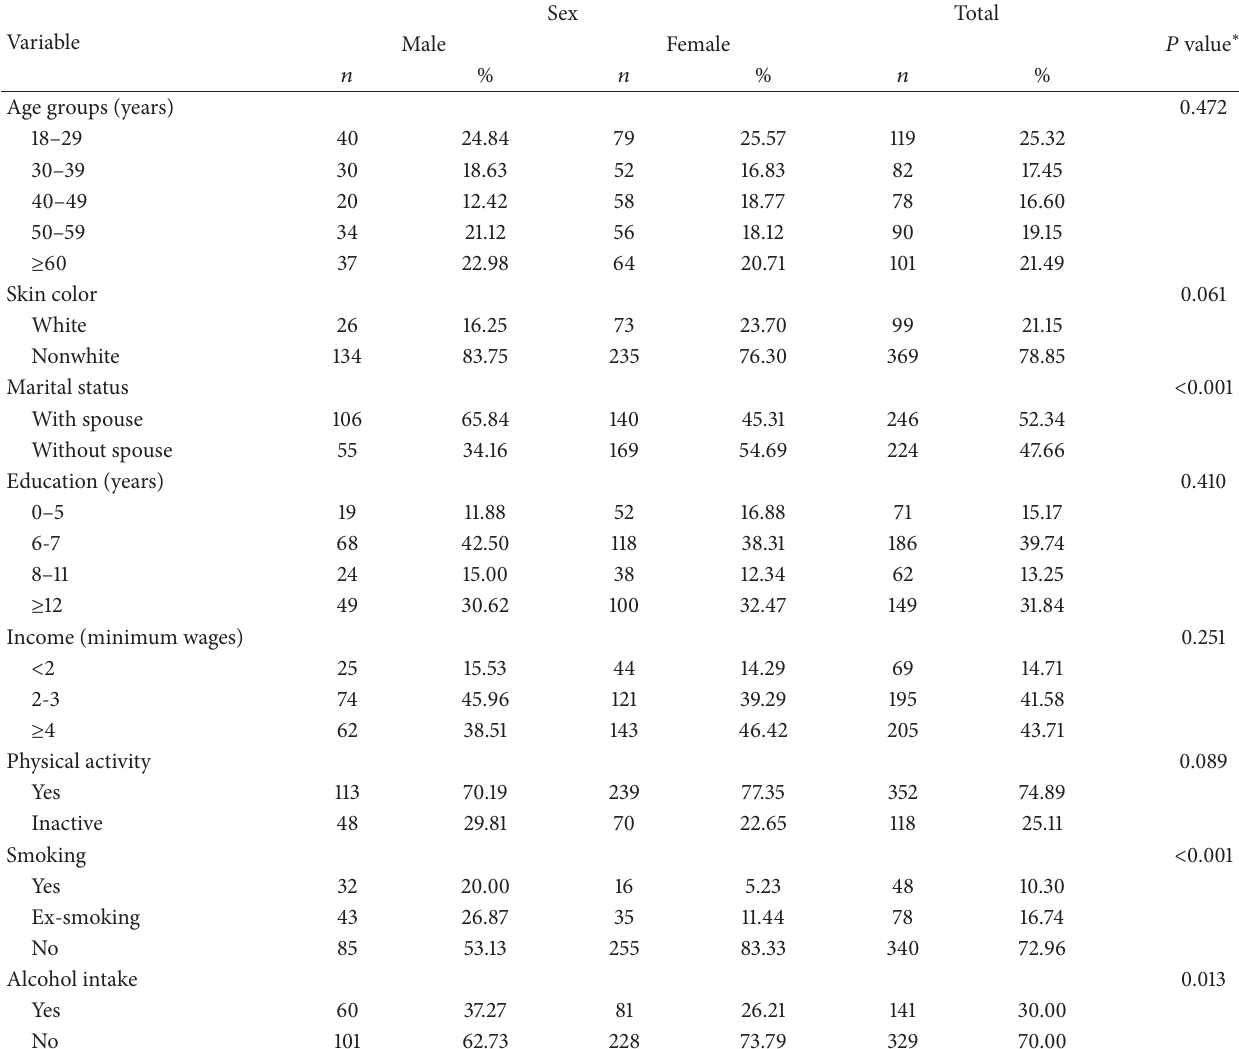
Table 1: Sociodemographic characteristics by sex. Montes Claros, Brazil,